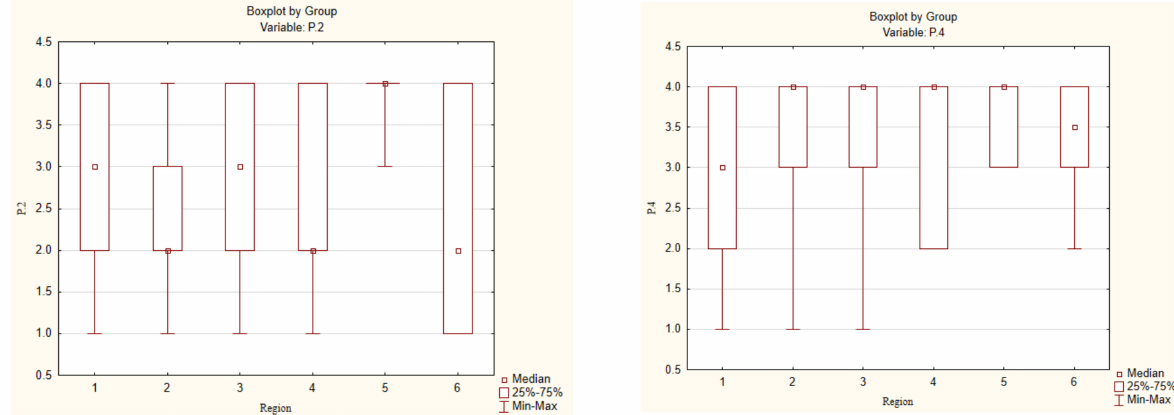
Figure 3. Box and whisker diagrams for practices P2 (Reducing opening and closing the door of the refrigerator) and P4 (Putting hot food into the refrigerator after cooling) from the category “energy